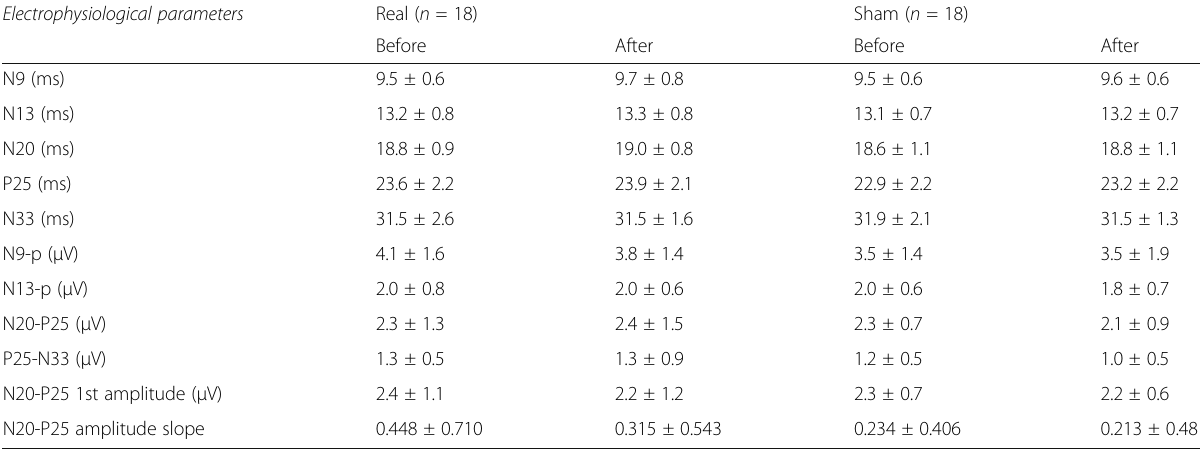
Table 3 Grand-average somatosensory evoked potentials (SSEPs) latencies and amplitudes in migraine patients ’ groups undergoing real or sham transcranial direct current stimulation (tDCS) before and after intervention Electrophysiological parameters